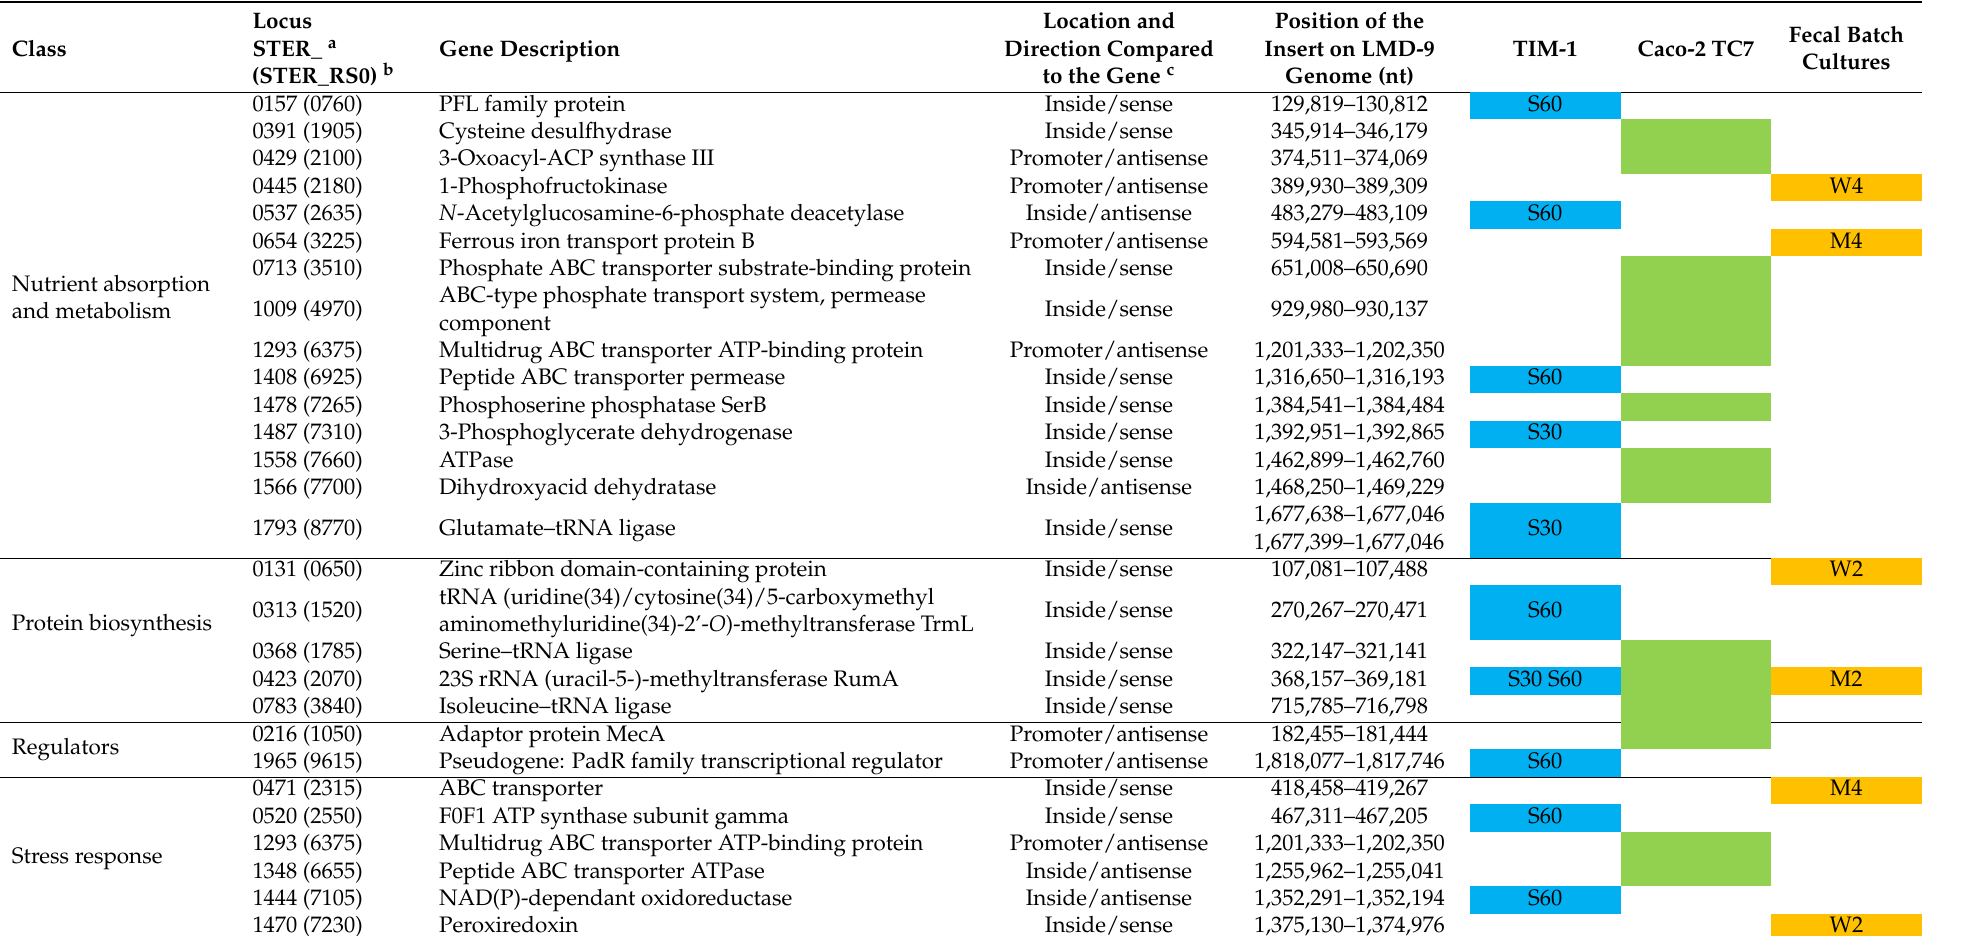
Table 4. Inserts from activated R-IVET library clones identified under simulated human digestive conditions and not associated with annotated promoter regions from S. thermophilus LMD-9